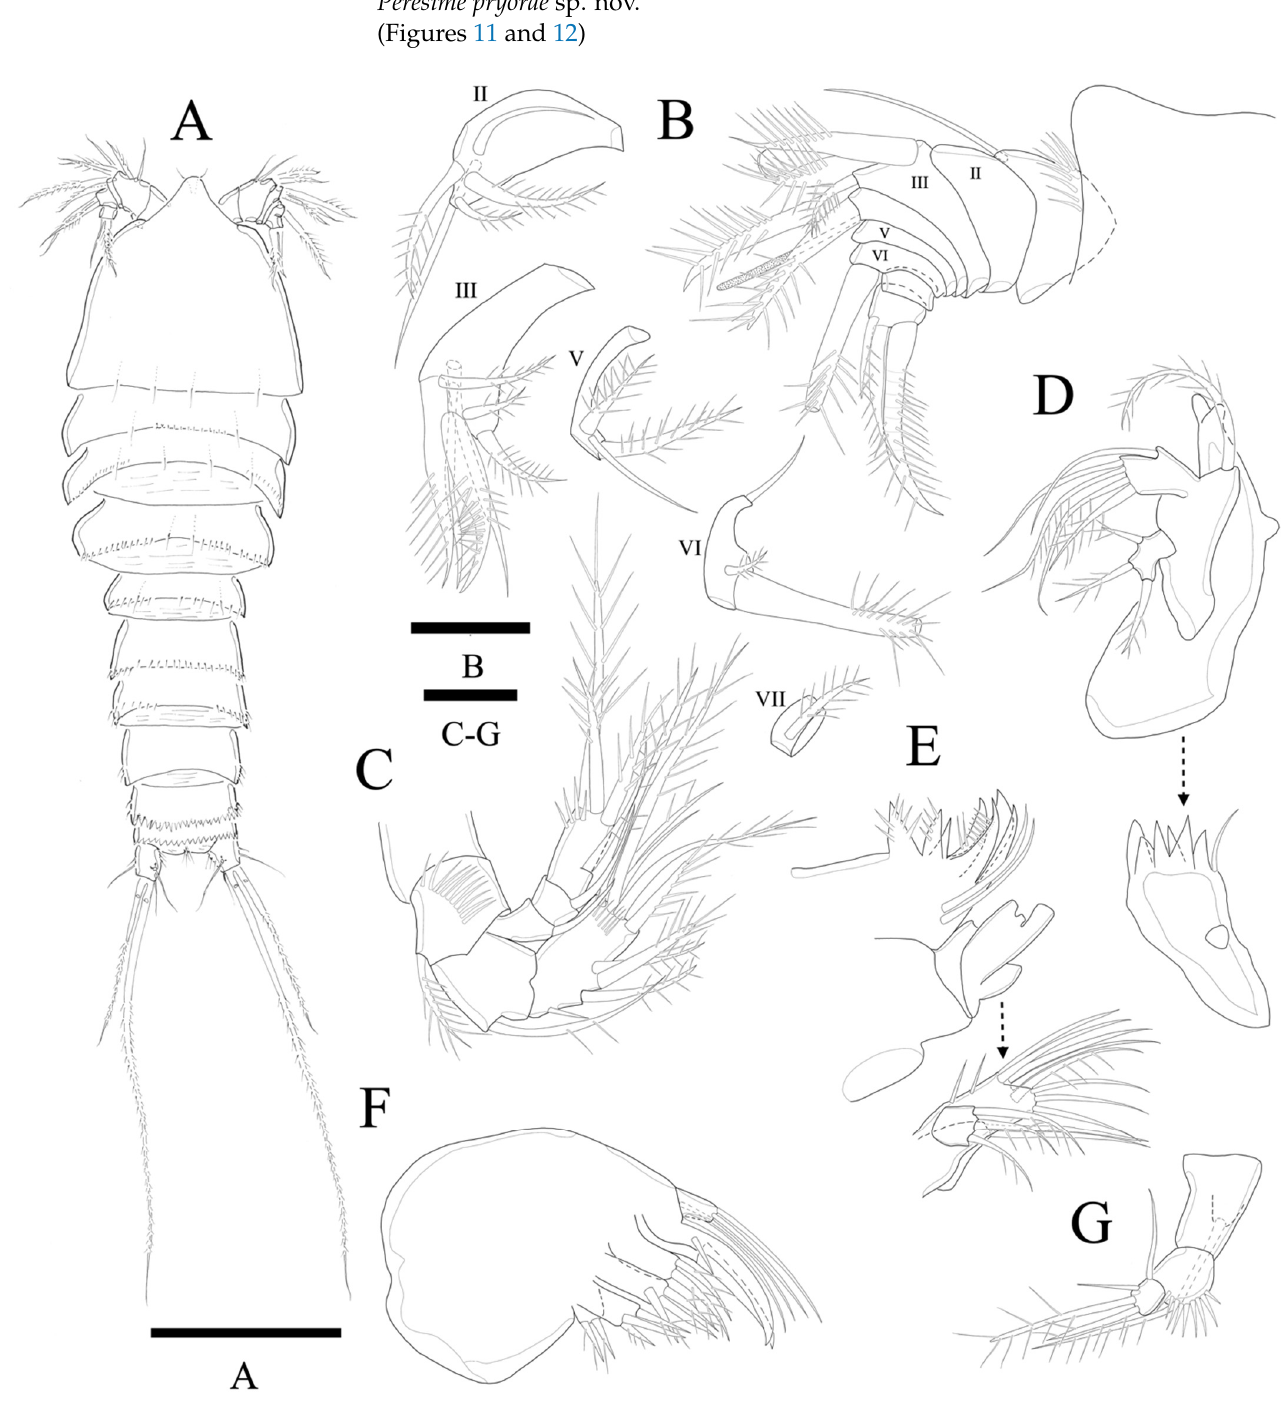
Figure 11. Peresime pryorae sp. nov. ( A ) Habitus, dorsal; ( B ) A1; ( C ) A2; ( D ) Mandible; ( E ) Maxillule; ( F ) Maxilla; ( G ) Maxilliped. Scale bars: ( A ) 100 µm; ( B – G ) 10 µm. Antennule (Figure 11B) eight-segmented. Segment 1 with row of strong spinules around proximal margin. Segments 2 and 3 subequal in length. Segment 4 with ae fused basally to strong pinnate seta. All setae pinnate except for two, two, one, one naked seta on second, third, fifth and sixth segments, respectively. Armature formula: 1-(1), 2-(2 + 3 pinnate), 3-(2 + 5 pinnate), 4-(1 pinnate + (1+ae)), 5-(1 + 2 pinnate), 6-(1 + 2 pinnate), 7-(1 pinnate), 8-(3 pinnate). Antenna (Figure 11C) four-segmented, comprising coxa, basis, and free two-seg- mented endopod. Basis with row of anterior spinules, with pinnate abexopodal seta.